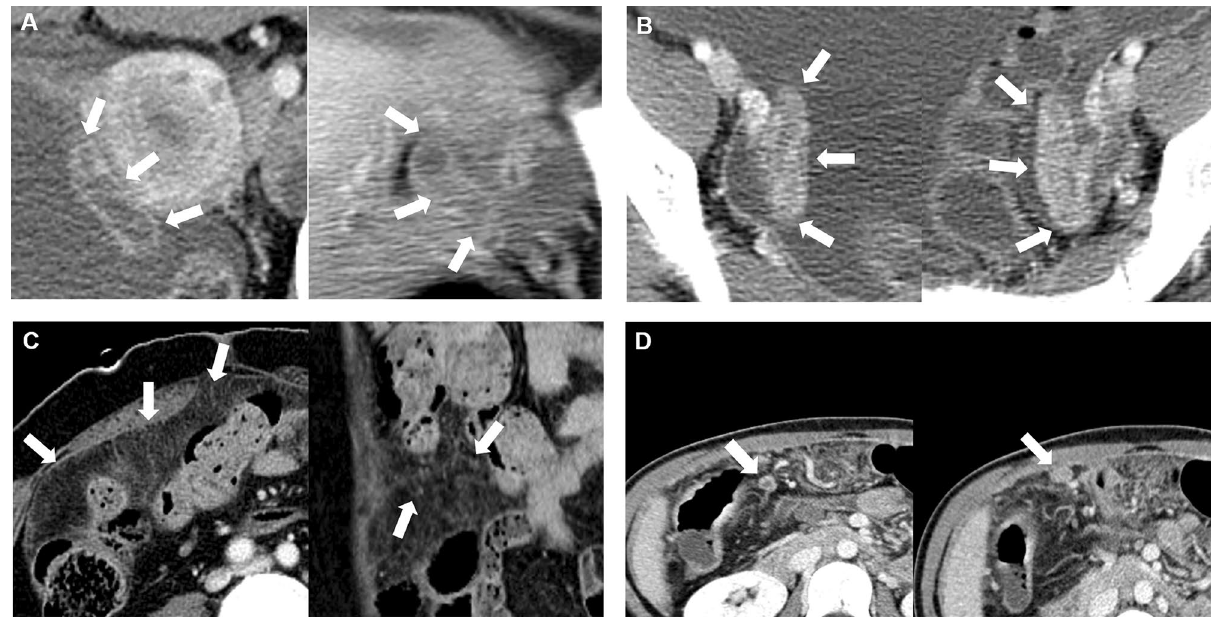
Figure 2. Representative cases of CT imaging features. ( A ) Hydrosalpinx, ( B ) fallopian tube enhancement, ( C ) peritoneal micronodule, and ( D ) peritoneal